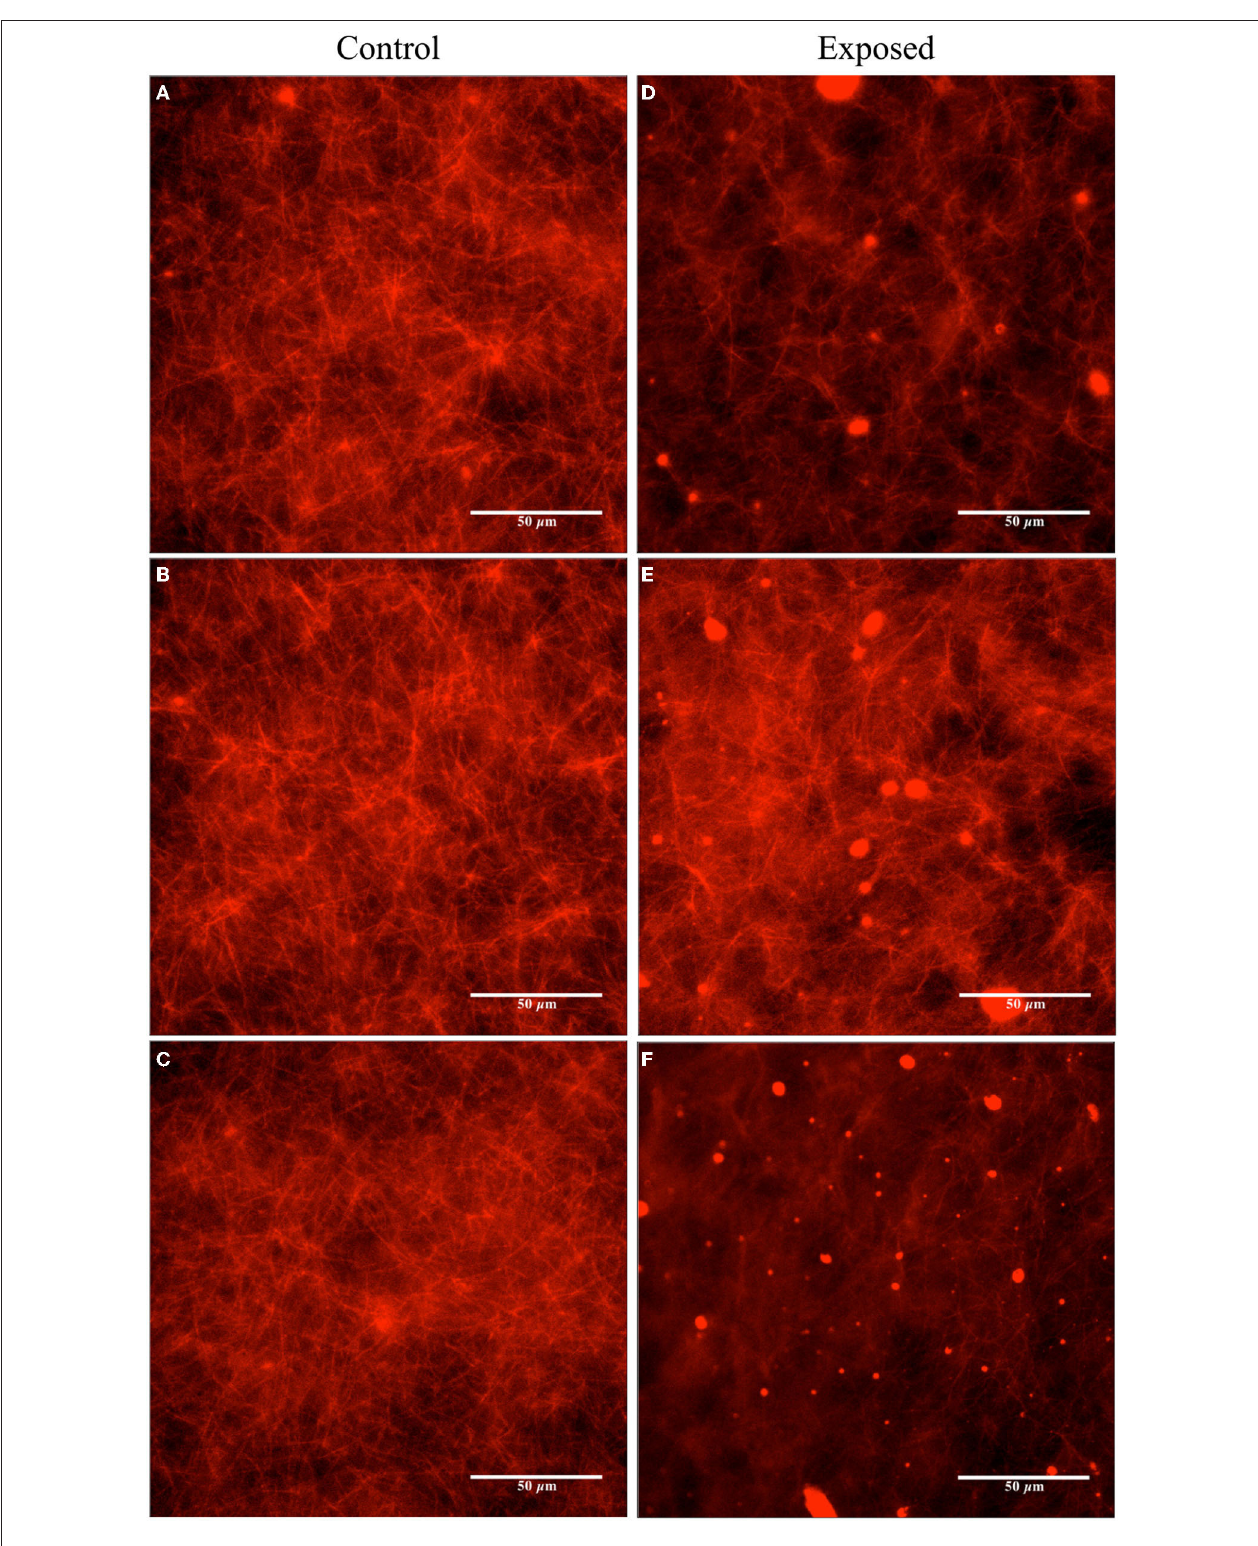
FIGURE 7 | Fluorescence microscopy images obtained for the unexposed and the Vielight LED-exposed MTs (labeled with rhodamine) stabilized in PEM-T (4 µ M Taxol and ∼ 2 µ M tubulin). The control group is shown on the left (A–C) and the exposed (2 h) on the right (D–F) . Images are representative of N = 3 independent replicate